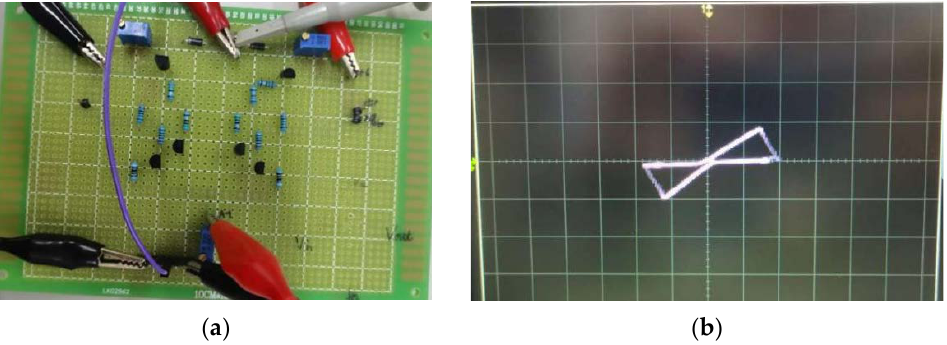
Figure 5. The i - v characteristic curve of the improved hysteresis circuit: ( a ) when V + = − V − = 2 V, ( b ) when V + = − V − = 6 V.